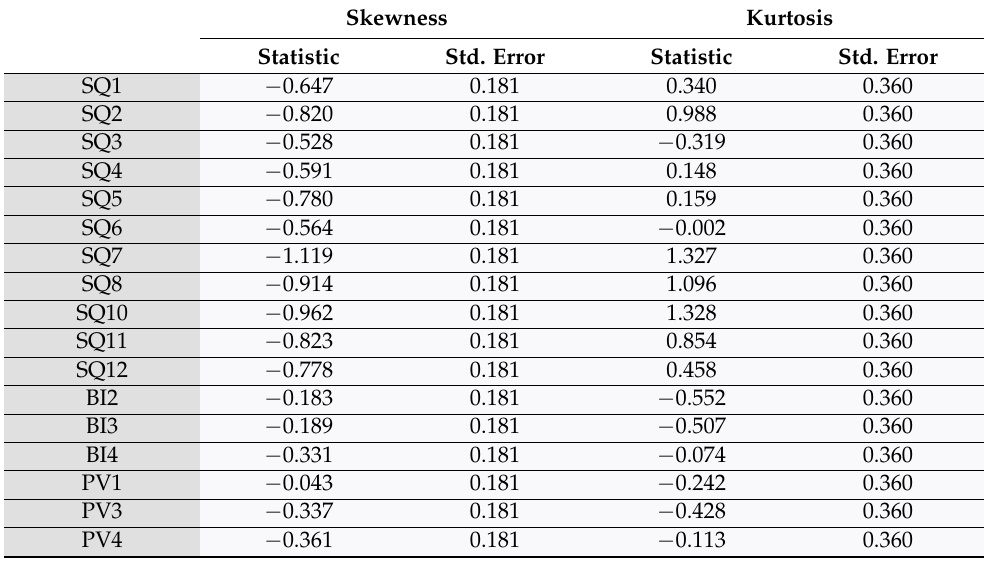
Table 3. Skewness and kurtosis of the factors (N = 180).